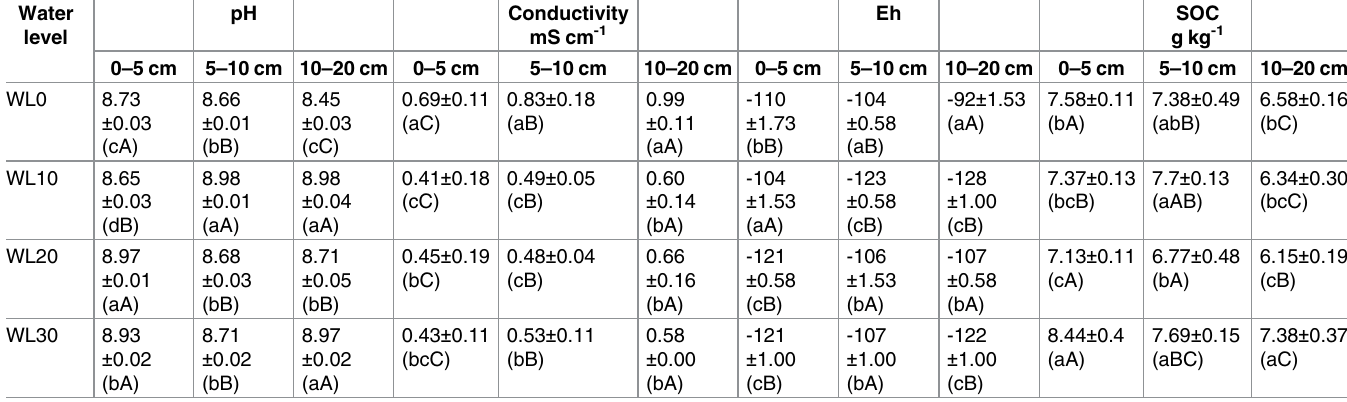
Table 2. Basic physical and chemical properties of soil in Hangzhou Bay Wetland in September.